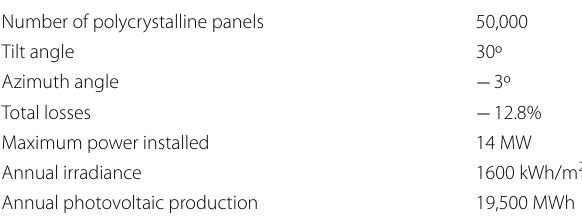
Table 11 Pico system design data with polycrystalline photovoltaic panels Number of polycrystalline panels